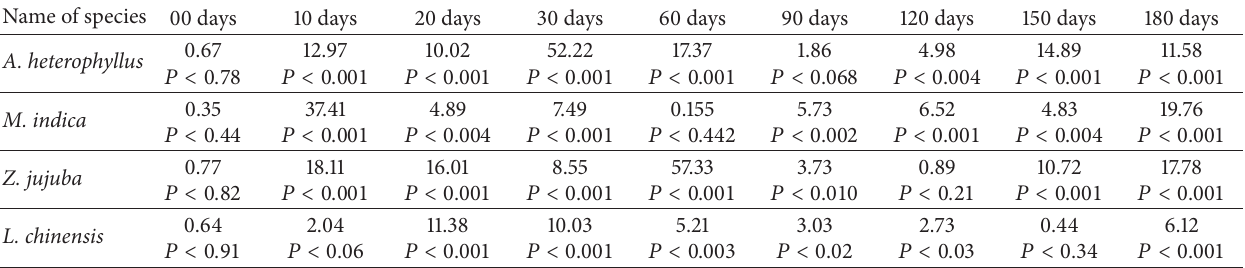
Table 6: Significant test of K concentration of leaf litter of the selected cropland agroforest horticultural tree species among dry and wet season.